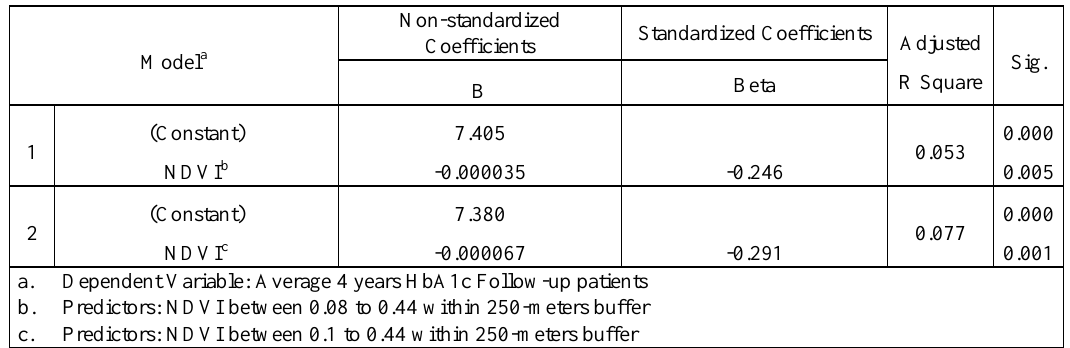
Table 5. Comparison of regression models using two different NDVI